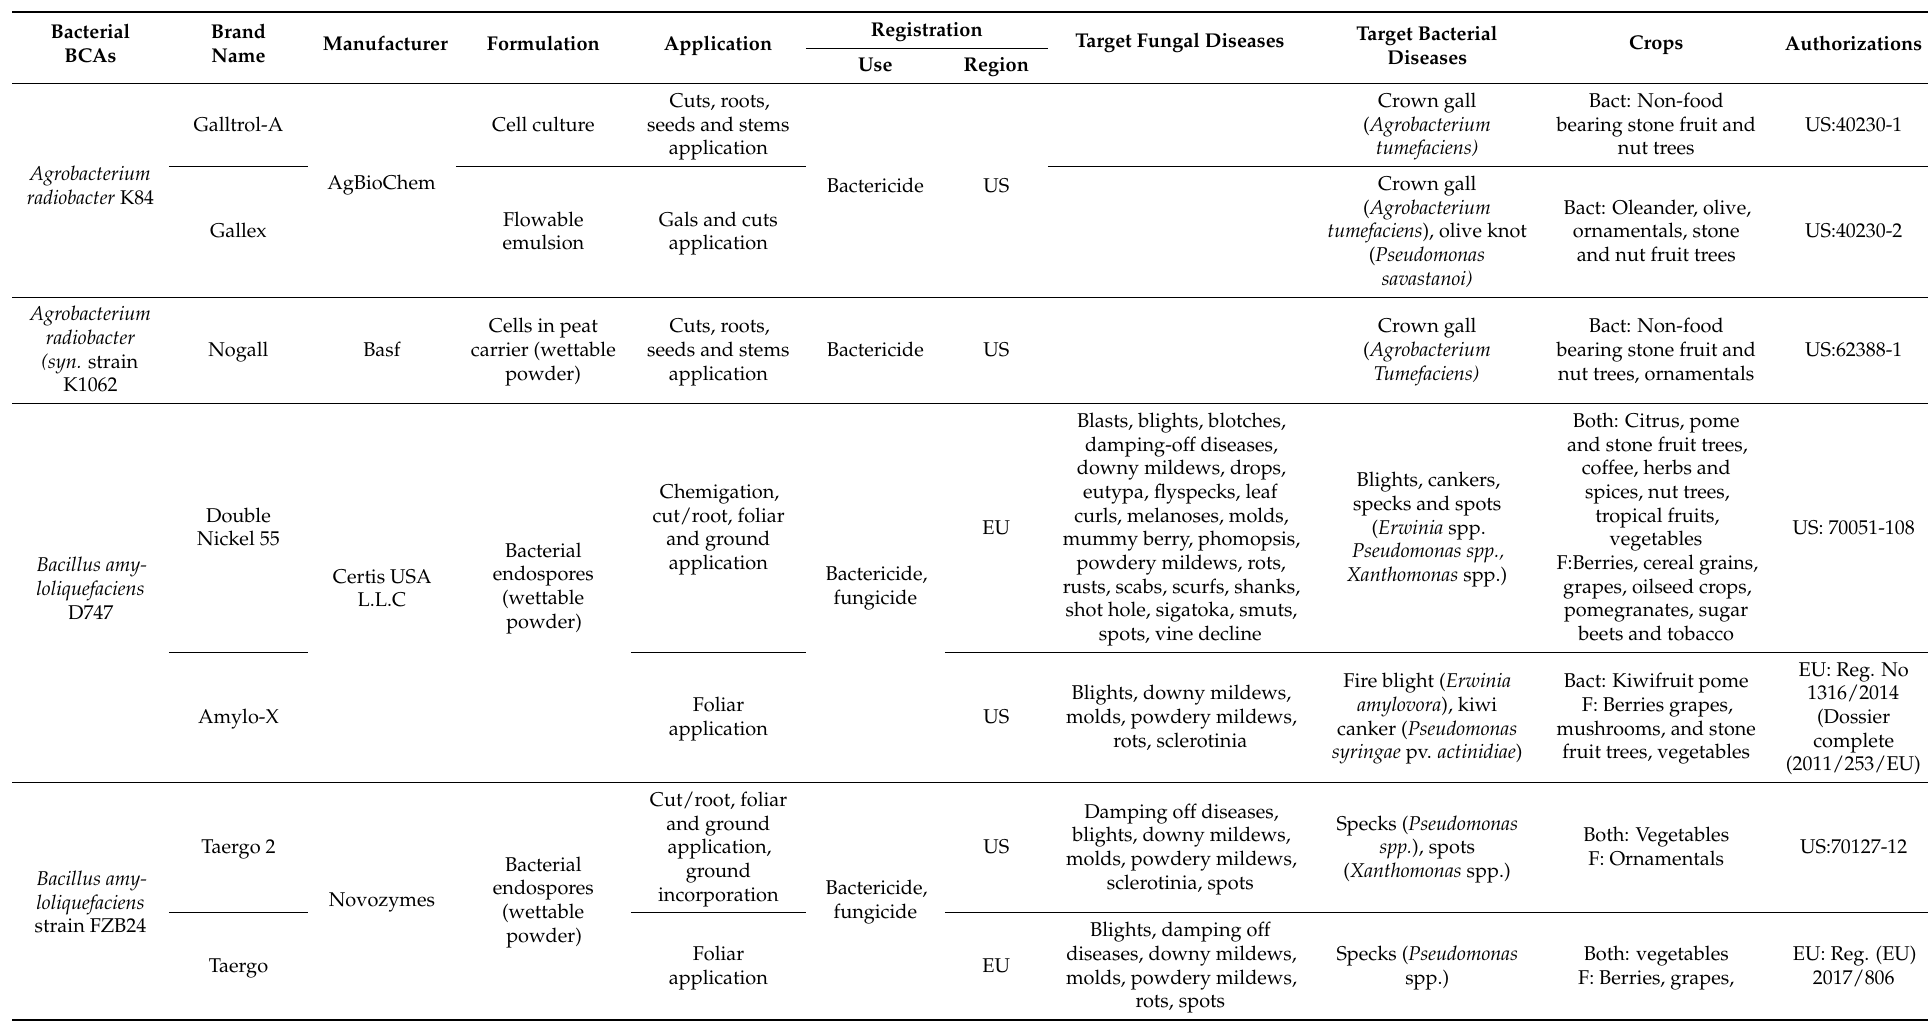
Table 1. Bacterial Biocontrol Agents (BCAs), currently registered as bactericides and fungicides in the European and American market. Target pathogens and plant hosts are listed based on label claims. Different colors in the target crop column indicate authorized use as bactericides (Bact), fungicides (F), or both (Both). Bacterial